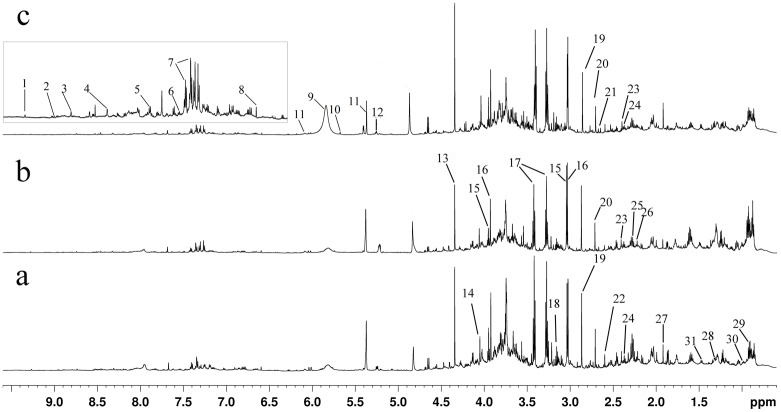
Typical 600 MHz 1H-NMR spectra of mice urine from Con (a), HFD (b) and Cur2(c) groups.Metabolites: 1, 1-methylnicotinamide; 2, Niacinamide; 3, Nicotinamide N-oxide; 4, Formate; 5, Hippurate; 6, Benzoate; 7, N-phenylacetylglycine; 8, trans-Aconitate; 9, Urea; 10, cis-Aconitate;11, Allantoin; 12, Glucose; 13, Tartrate; 14, Creatinine; 15, Creatine; 16, Creatine phosphate; 17, Taurine; 18, Choline; 19, Trimethylamine; 20, Dimethylamine;21, Citrate; 22, Methylamine; 23, Succinate; 24, Pyruvate; 25, Acetoacetate; 26, acetone; 27, Acetate; 28, Lactate; 29, Leucine / isoleucine; 30, Valine; 31, Alanine.